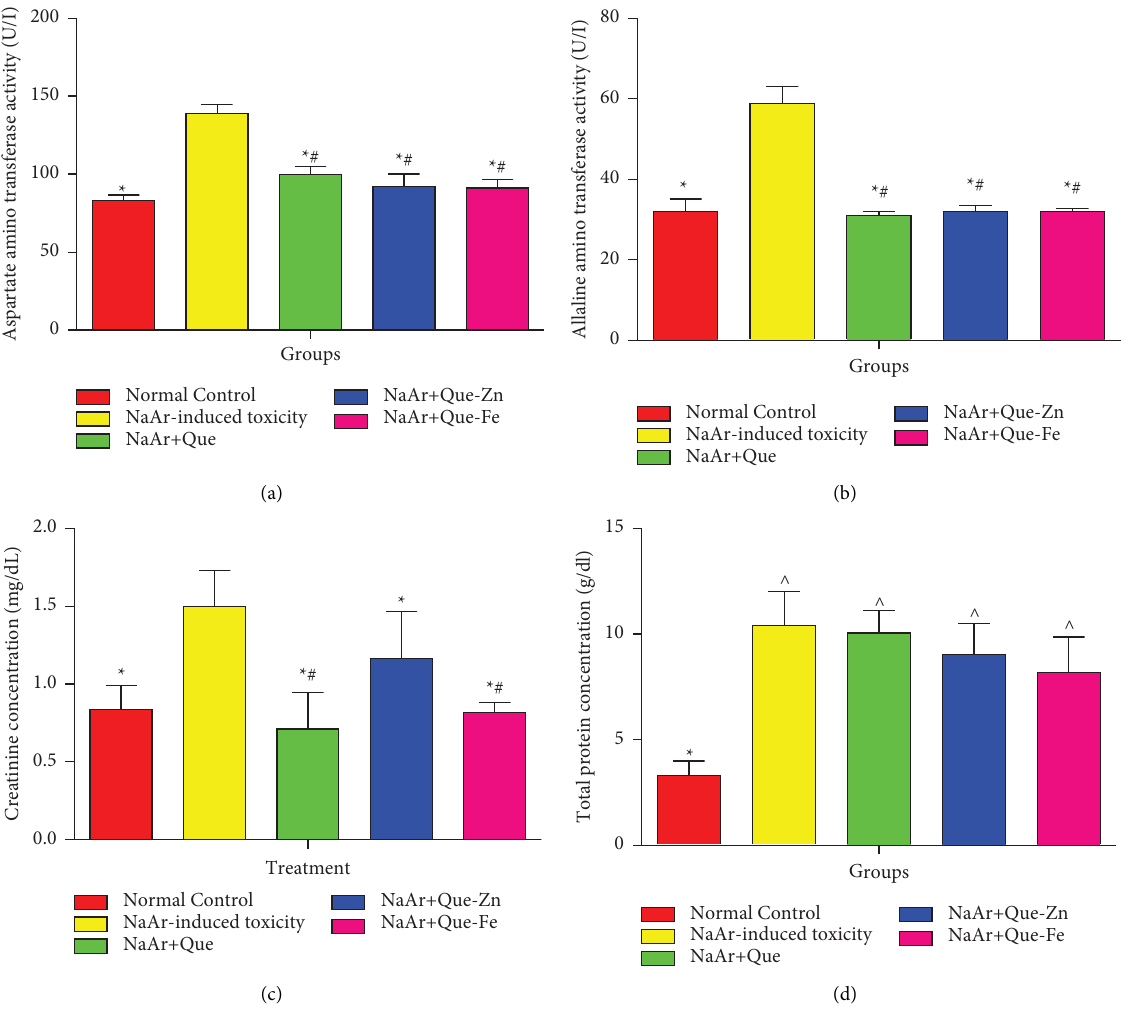
Figure 4: (a) Quercetin and its metal complexes normalized aspartate aminotransferase levels in sodium-arsenite induced toxicity in rats. (b) Quercetin and its metal complexes decreased the elevated alanine amino transferase levels in sodium-arsenite induced toxicity in rats. (c) Quercetin and its metal complexes ameliorate the increased levels of creatinine in sodium-arsenite intoxicated rats. (d) Efect of quercetin and its metal complexes on levels of total protein in sodium arsenite-induced toxicity. Data are presented as the mean ± SD, ∗ � values difer signifcantly from untreated sodium arsenite-intoxicated rats ( P < 0 . 05), # � values difer signifcantly from normal control rats ( P < 0 . 05), ∧ � values did not difer signifcantly from untreated sodium arsenite-intoxicated rats ( P < 0 . 05). Normal control, NaAr-induced tox- icity � rats administered sodium arsenite and left untreated, NaAr +Quer � rats administered sodium arsenite and treated with 30mg/kg quercetin, NaAr+ Quer-Zn � rats administered sodium arsenite and treated with 30mg/kg quercetin-zinc, and NaAr+Quer-Fe � rats administered sodium arsenite and treated with 30mg/kg